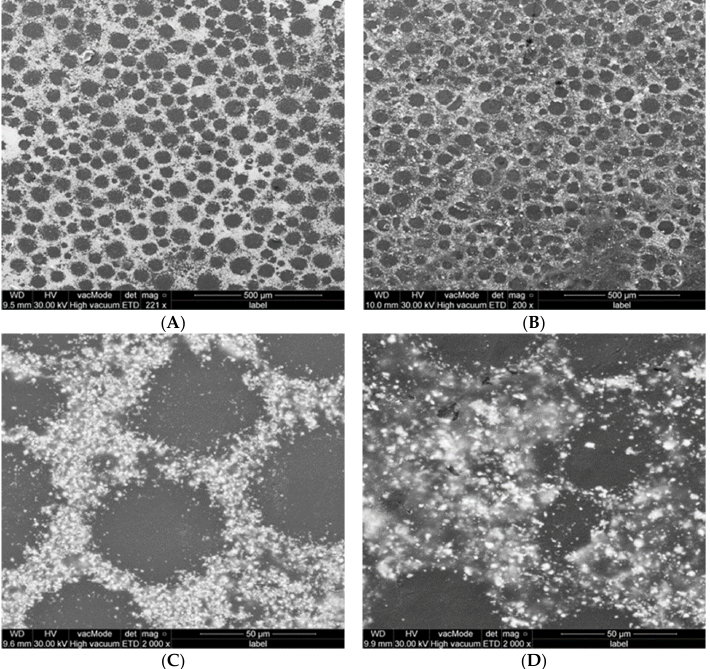
Figure 8. SEM photos of PMMA-MgO nanocomposite discs prepared by non-ethanol-assisted ( A , C ) and ethanol-assisted ( B , D ) mixing.